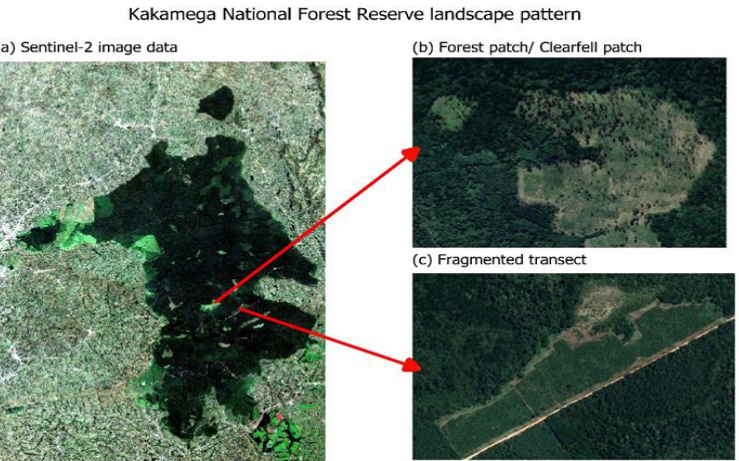
Figure 3. True colour composite ( a ) showing forest patch ( b ) and fragments ( c ) in Kakamega Forest.